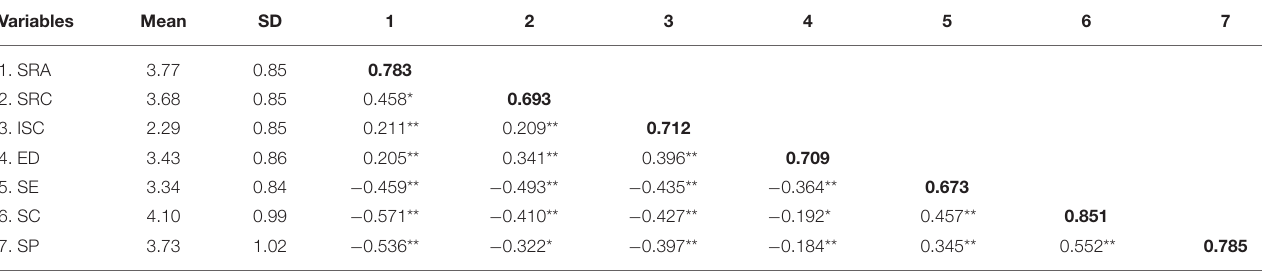
TABLE 2 | Means, SD, and correlation coefficients among variables.